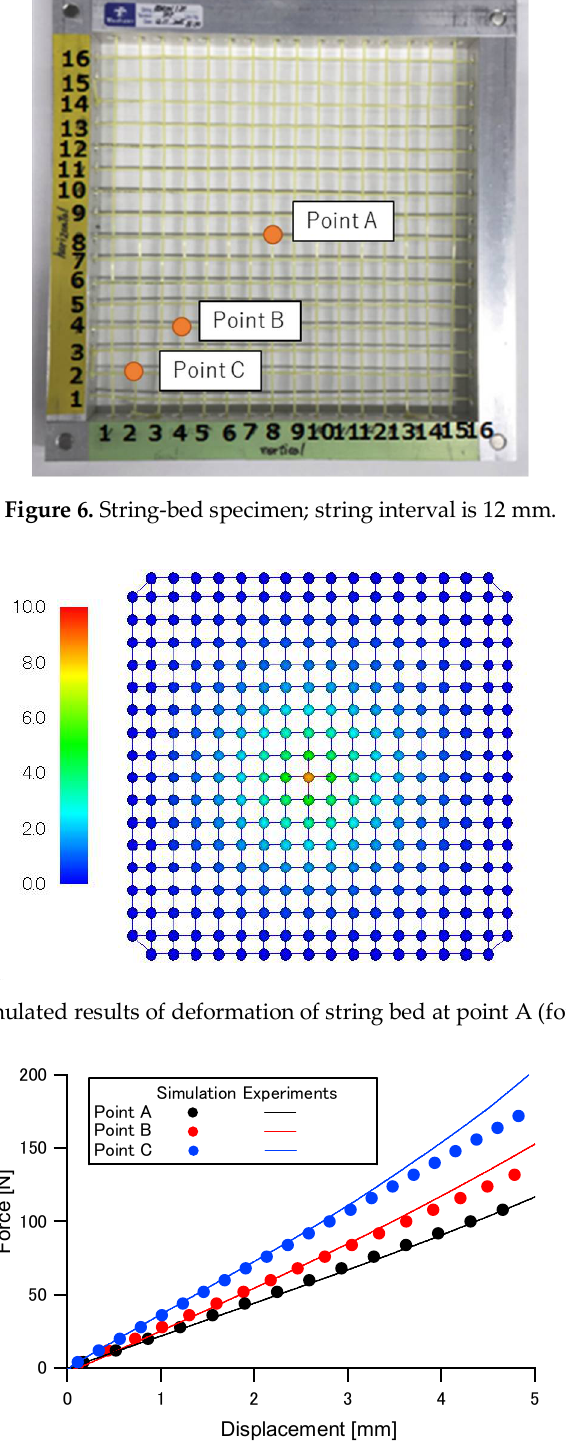
Figure 8. Relationships between displacement and force in out-of-plane